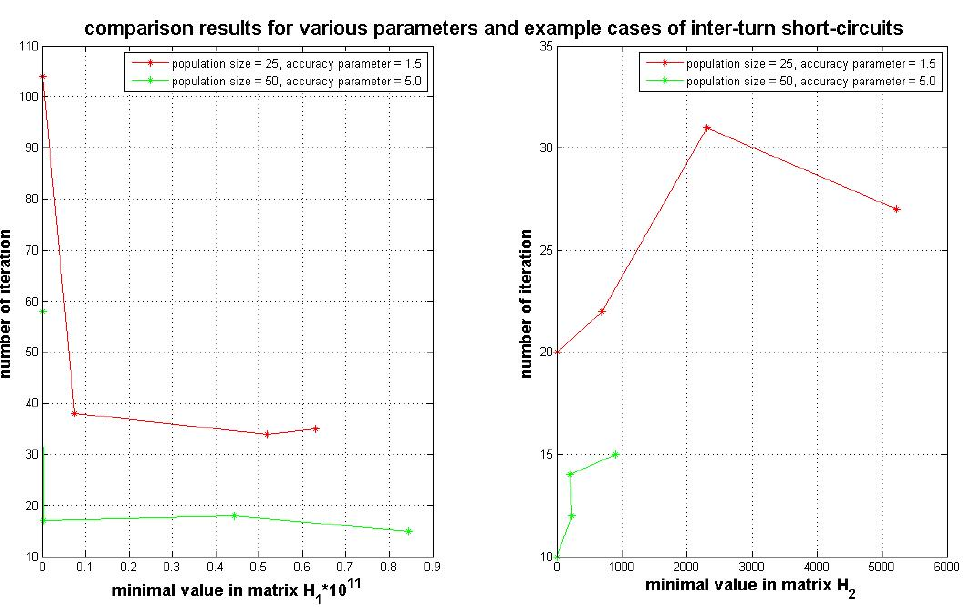
Figure 4. Comparison of the obtained number of iterations and the calculated minimum values of the matrices H 1 and H 2 , respectively.